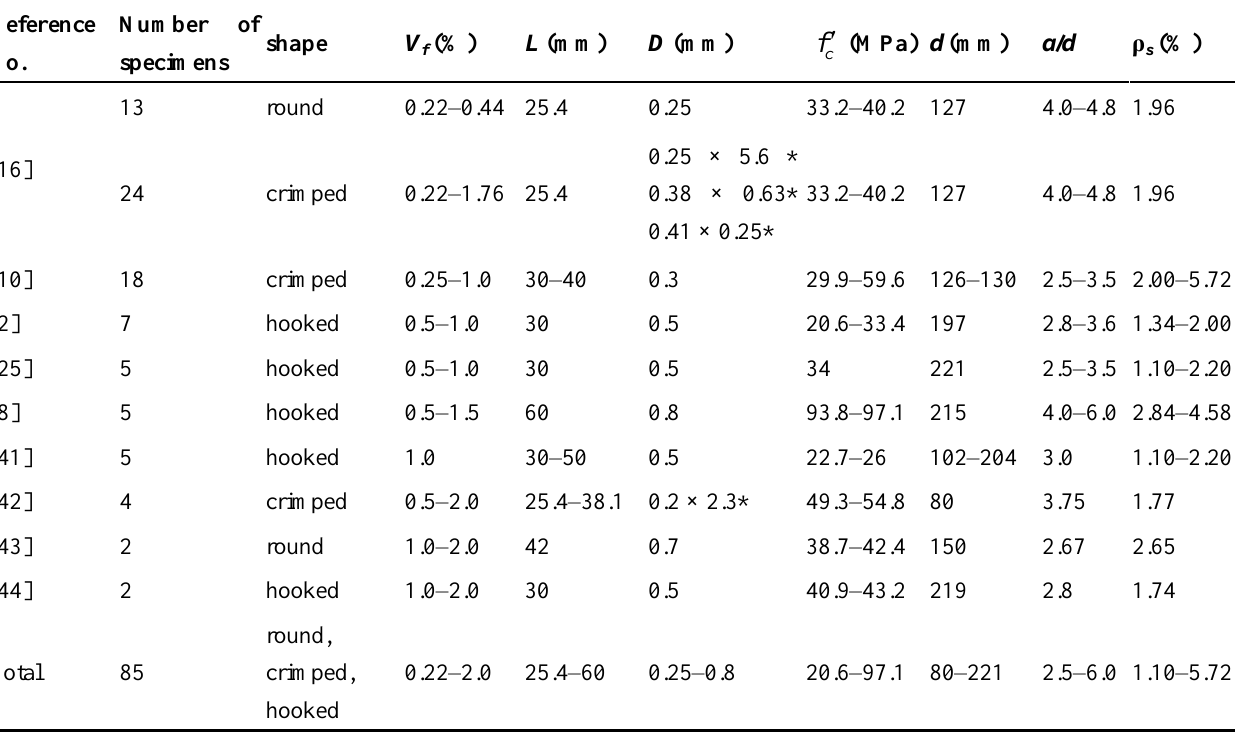
Table 1. Dimensions and properties of SFRC